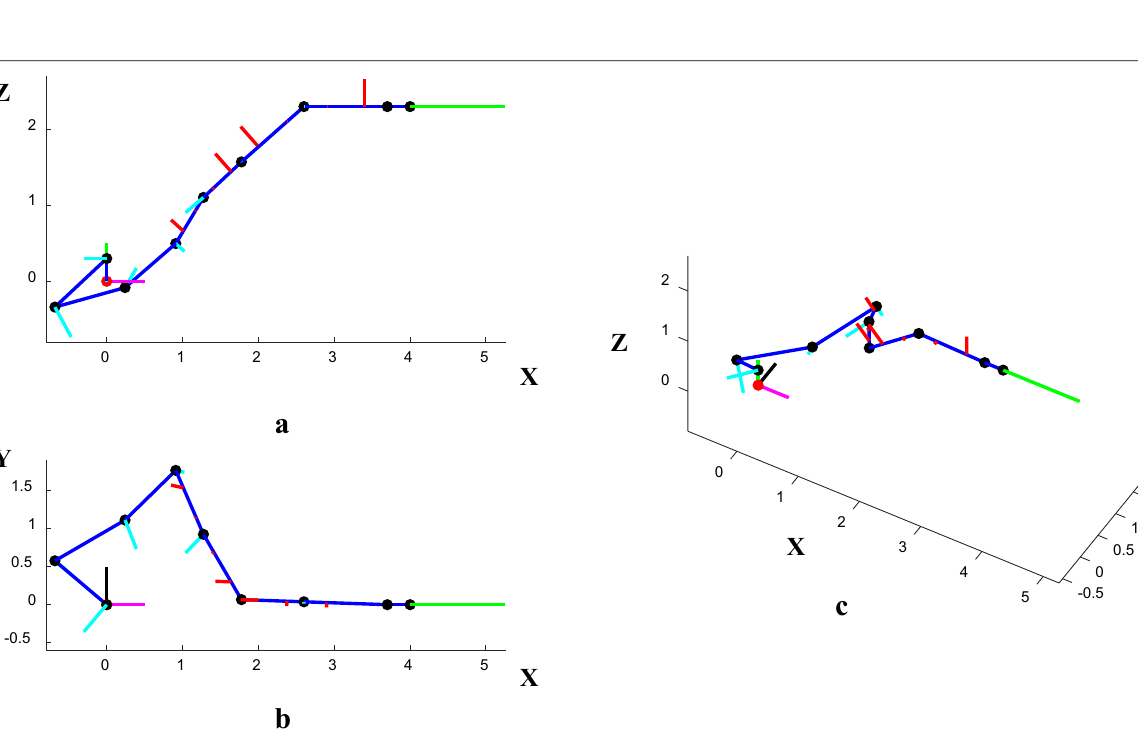
Fig. 9 The simulation arm and flying watch thrusts under the second level watch-actuator cooperation when the external reaction force on the end effector is [125,0,0] N (reduction rate 35.6%). a Front view. b Top view. c 3-D =